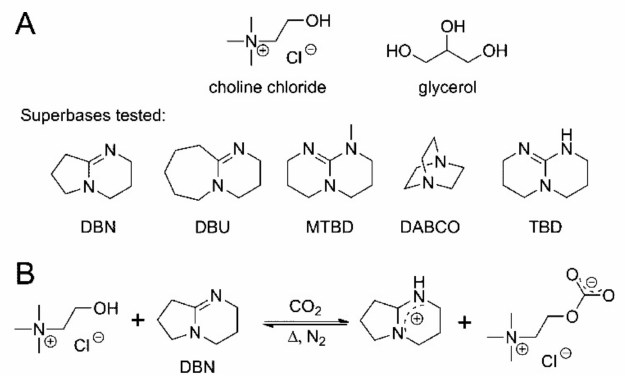
Figure 6. ( A ) Structures of the DES components: choline chloride, glycerol, and various superbases. ( B ) Proposed reaction scheme for superbase-promoted CO 2 capture using a task-specific DES. In this scheme, choline chloride and the superbase DBN are shown for illustration; however, a similar reaction is believed to be operative for the other superbases as well as for CO 2 binding to the multiple alcohol functionalities of glycerol (Reprinted with permission from Ref. [77]. Copyright (2014) American Chemical